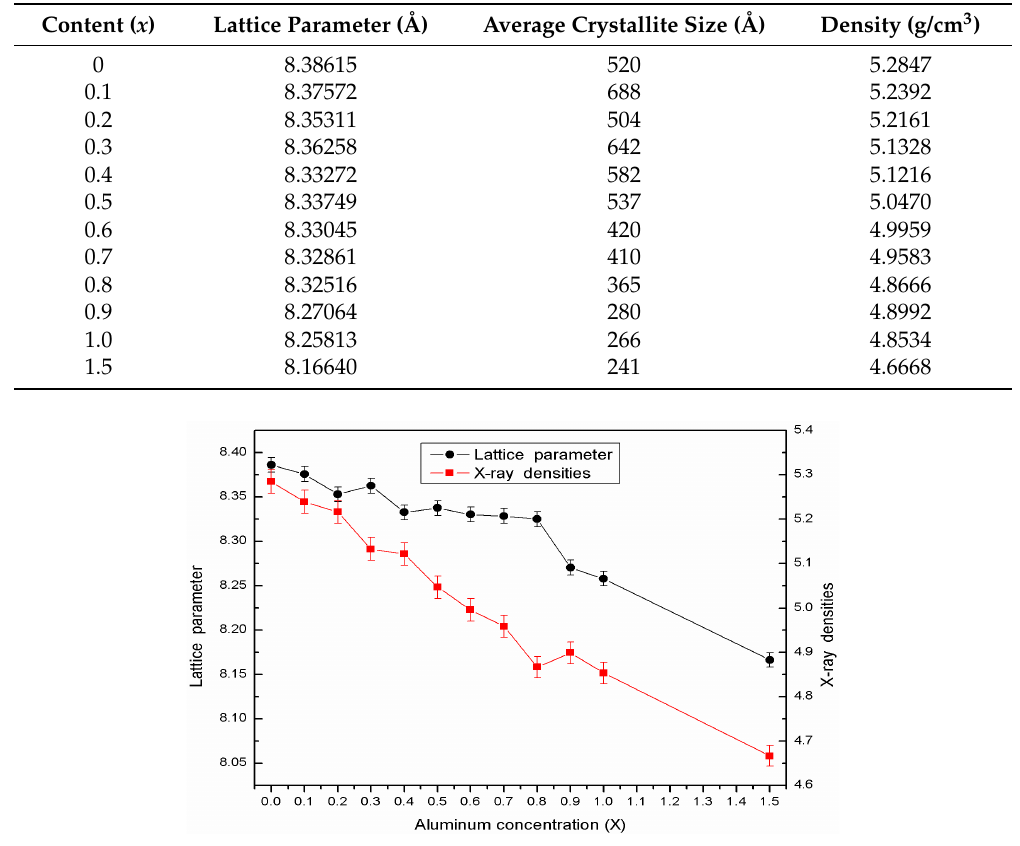
Figure 2. The change in the lattice parameter and X-ray densities of CoAl x Fe 2 − x O 4 .